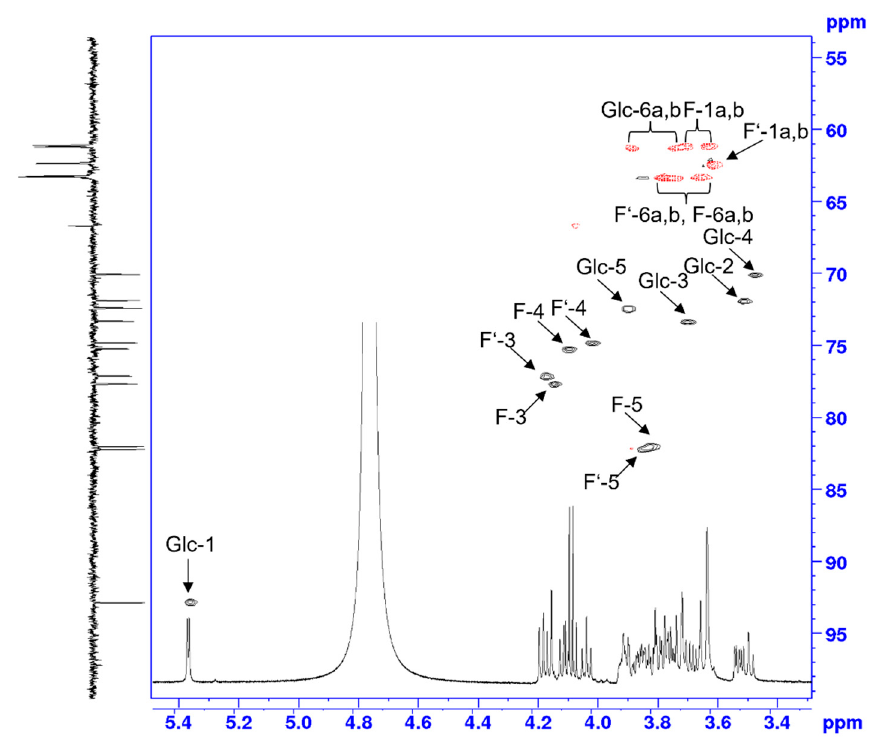
Figure 11. Expansion plot of the gHSQC spectrum of neokestose with 1 H and 13 C projections and assigned 1 H/ 13 C NMR signal.